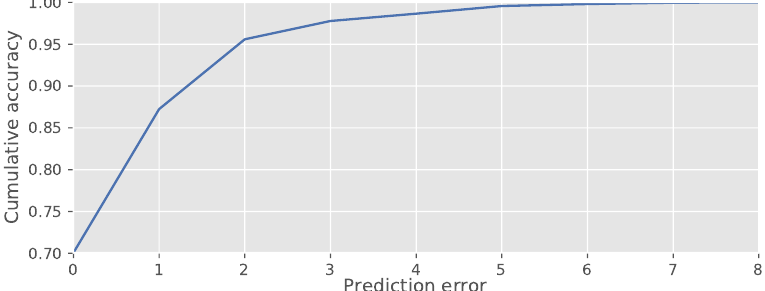
Figure 8. Fraction of plants where the estimated growth stage has a deviation of up to x in the counted number of leaves.